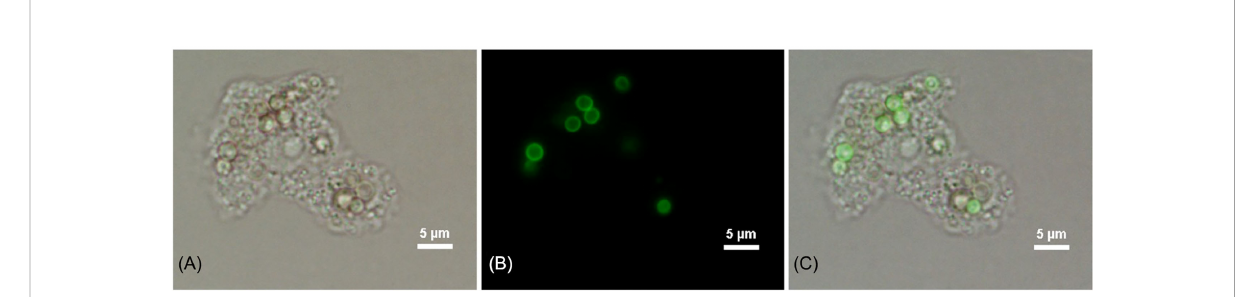
FIGURE 1 Phagocytosis image of 2 h post-incubation of A. castellanii with FITC-labeled T. marneffei conidia. Corresponding bright fi elds (A) , fl uorescence panel (B) and a merged channel showing the overlapping of images (C) . The picture was taken under 1,000x magni fi cations with a Nikon Eclipse 50i fl uorescence